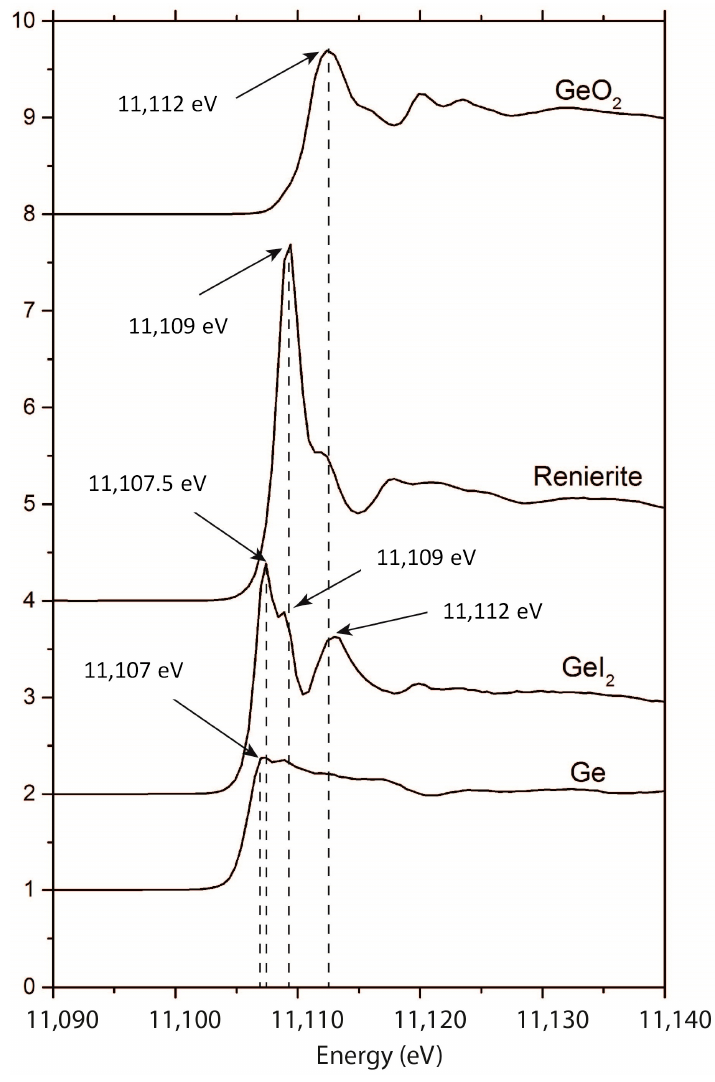
Figure 4. Experimental spectra of standards GeO 2 , renierite, GeI 2 , and Ge. In this study, spectra were identified using the position of the white line instead of using the edge of the spectra, because, in the samples, GeI 2 displays three peaks due to its partial oxidation to GeI 4 . The measured and calculated positions for peak values are similar and are 11,106.5 eV for Ge metal, 11,109 eV for renierite, and 11,112 eV for GeO 2 . Concerning GeI 2 , three peaks are visible due to GeI 2 oxidation: 11,107.5 eV corresponds to GeI 2 , and 11,108.5 eV corresponds to GeI 4 (Ge 4+ in coordination with four I atoms of electronegativity close to that of sulphur). The last peak on the experimental GeI 2 spectrum falls at the same energy as that of GeO 2 (11,112 eV).